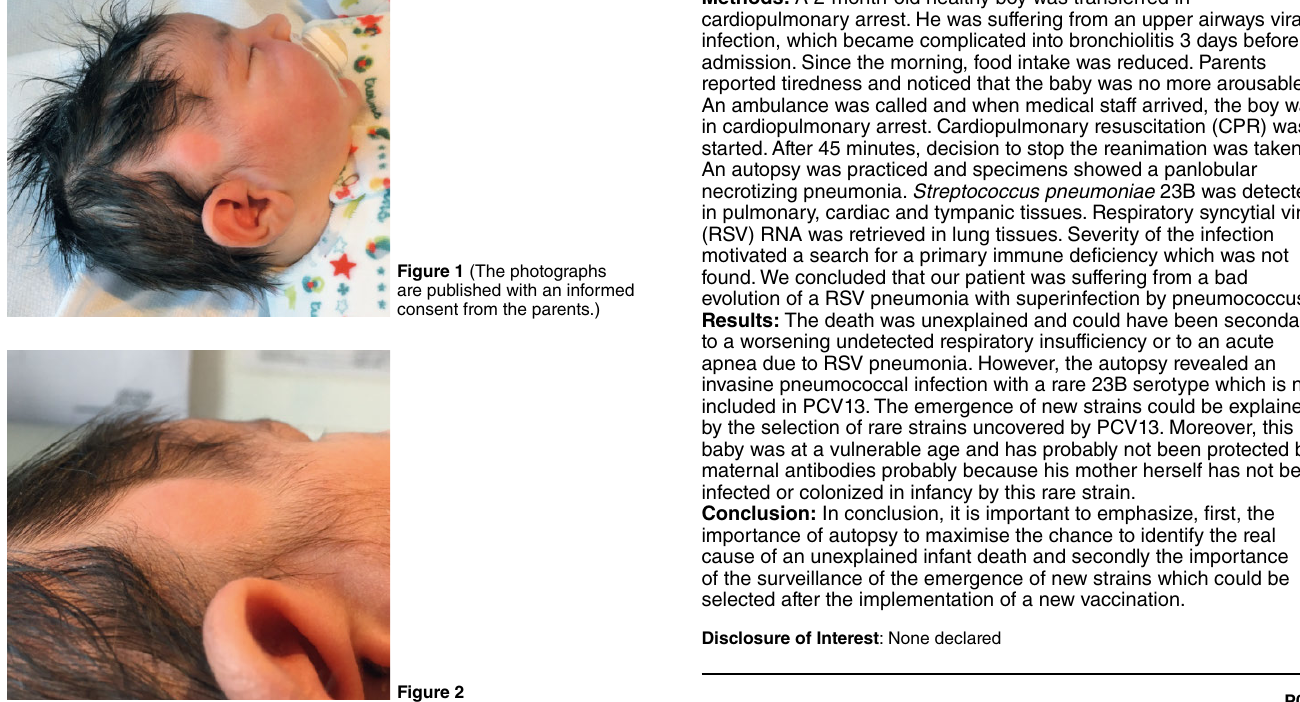
Figure 1 (The photographs are published with an informed consent from the